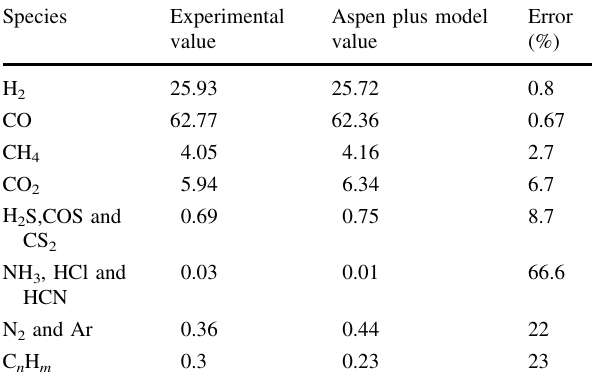
Table 11 Comparison of simulation results with experimental results (mole fraction) Species Experimental